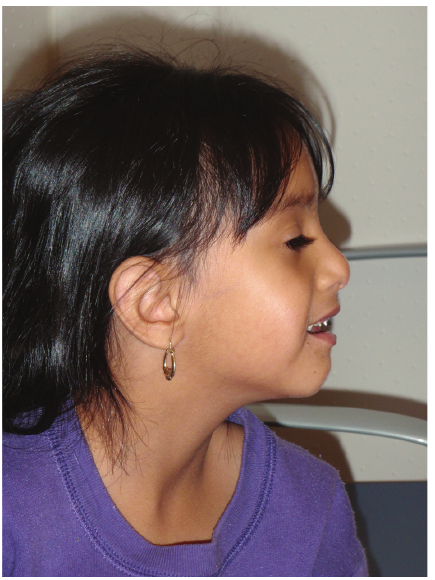
Figure 4: Patient at age of 4 years. Used with